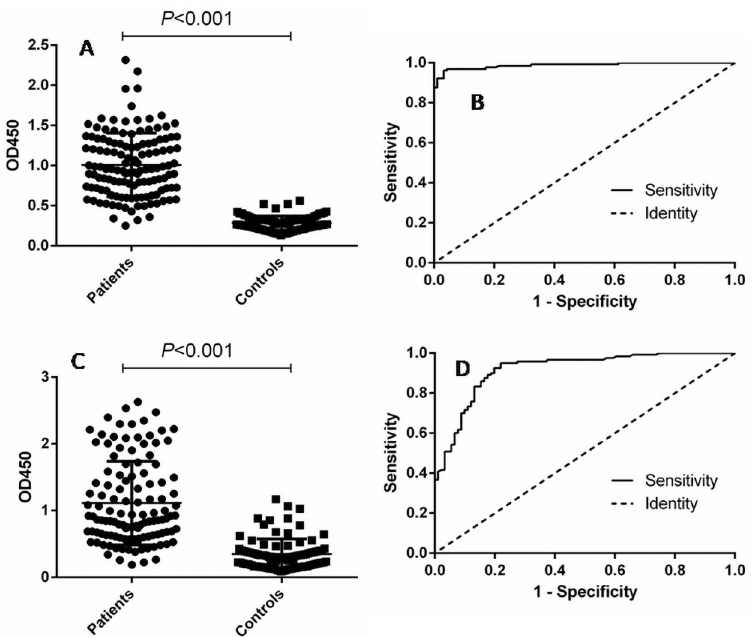
Fig 3. Comparison of fusion protein and LPS in detecting human brucellosis positive and negative sera. (A) Dotplot result of iELISA assay with fusion protein. (B) ROC analysis of iELISA assay with fusion protein. (C) Dotplot result of iELISA assay with LPS antigen. (D) ROC analysis of iELISA assay with LPS antigen.